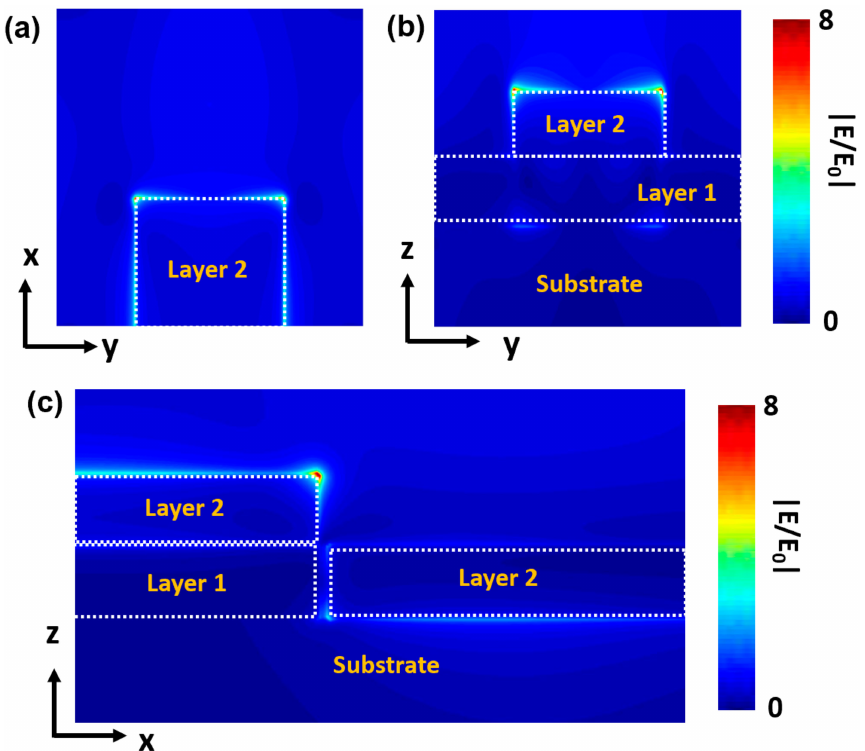
Figure 6. ( a ) Top view and cross-sectional view for the ( b ) z-y plane and ( c ) x-z plane of the calculated electric field distribution on the 10-nm Au nanogap with 240-nm-length excited by a 532-nm